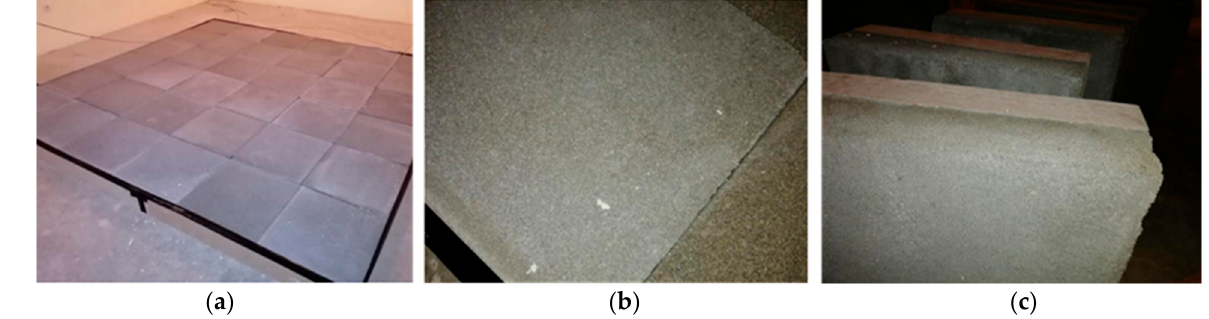
Figure 4. Porous concrete sample tested in the reverberant room. ( a ) Specimen with approximate area of 10 m 2 , ( b ) surface sample detail, and ( c ) sample detail in cross-sectional view, with porous concrete layer over a concrete structural layer.